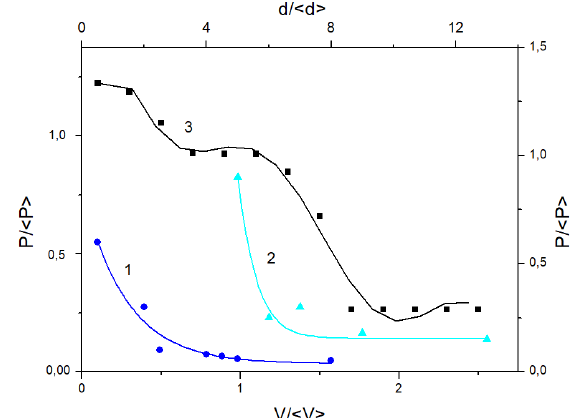
Figure 7. Normalized by the average size (abscissa) and probability P (ordinate) d -size distribution curves of cell ( 1 ) micrograins ( 2 ) in Ni after 50% rolling data from [46] and propagation velocity V of the PLC bands ( 3 ) in Ni under uniaxial tensile.